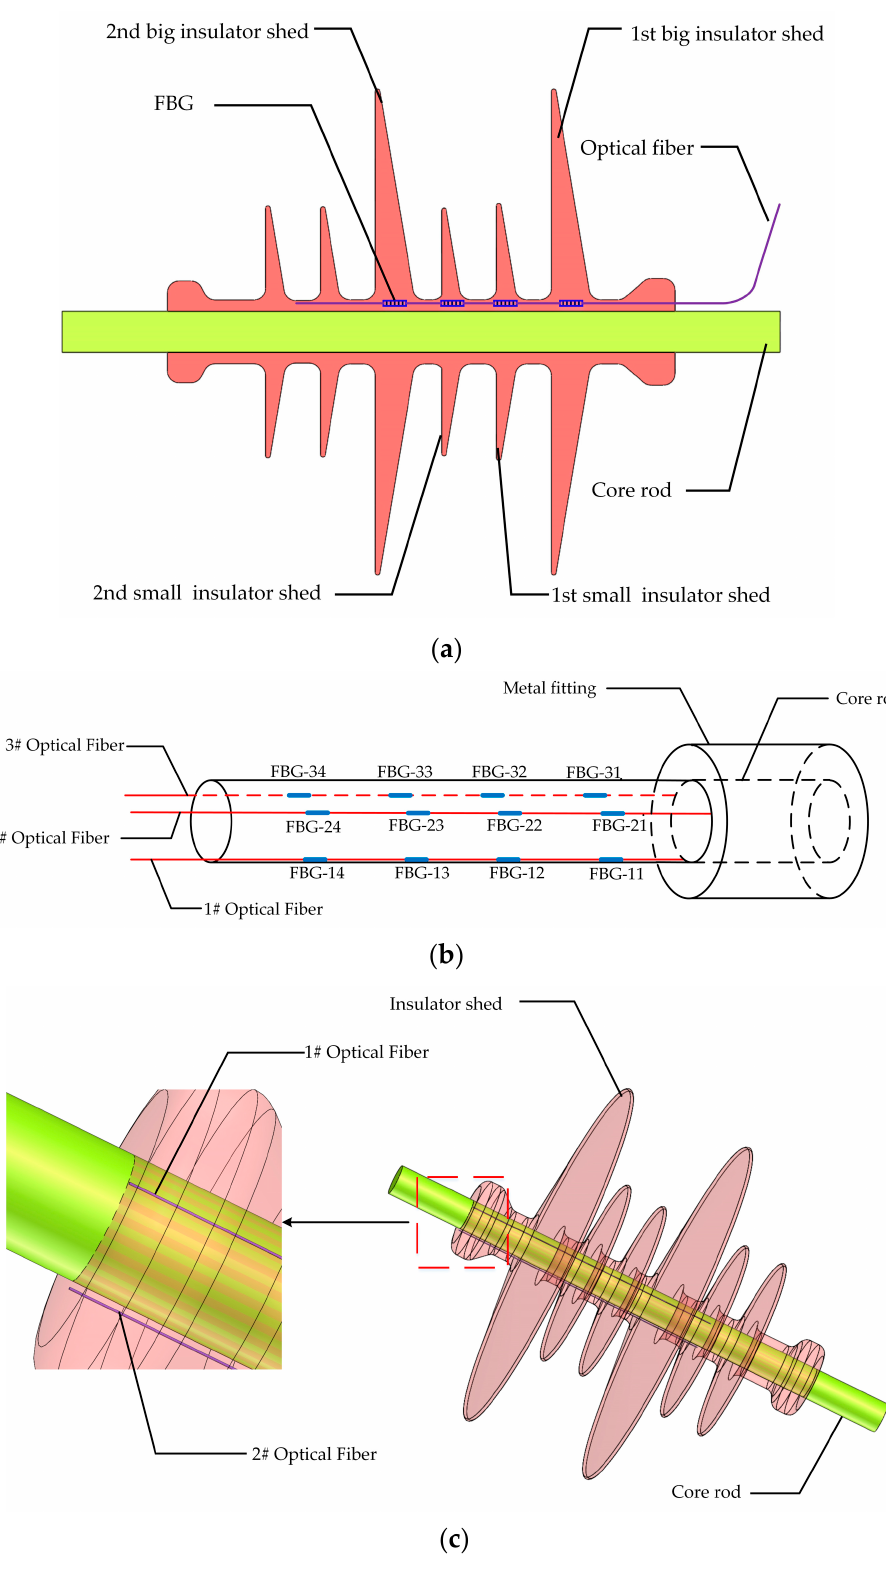
Figure 3. The diagram of optical fiber embedded position distribution. ( a ) Relative positions between FBGs and insulator sheds; ( b ) FBG distribution on the composite insulator, ( c ) Relative positions between FBGs and composite insulator.